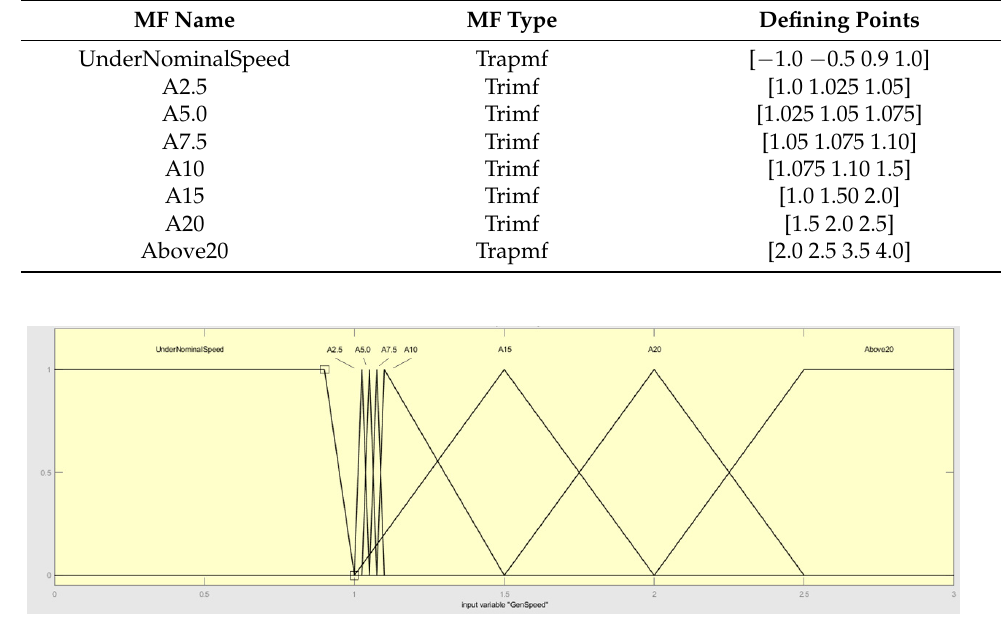
Figure 6. Membership functions of the generator speed input.